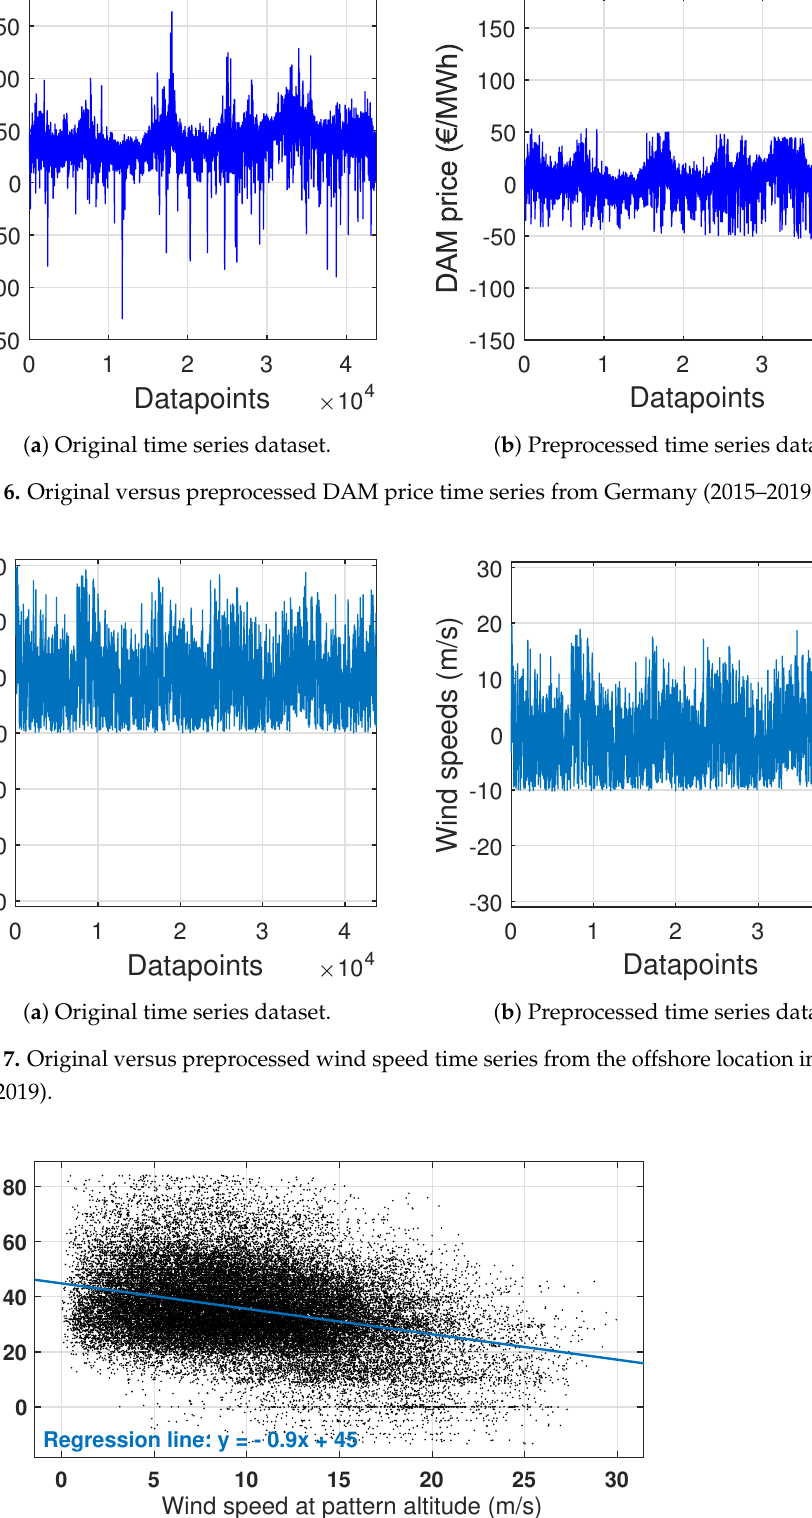
Figure 8. Regression analysis results of the DAM prices and wind speeds from Germany (2015–2019). The R 2 statistic of 0.11 indicates that the model did not fit the data perfectly.